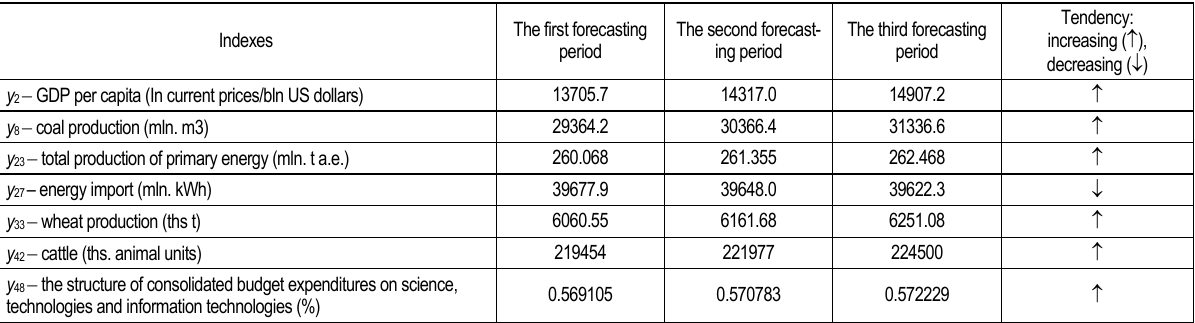
Table 4. Forecasting meanings of indexes of socioeconomic state of Brazil